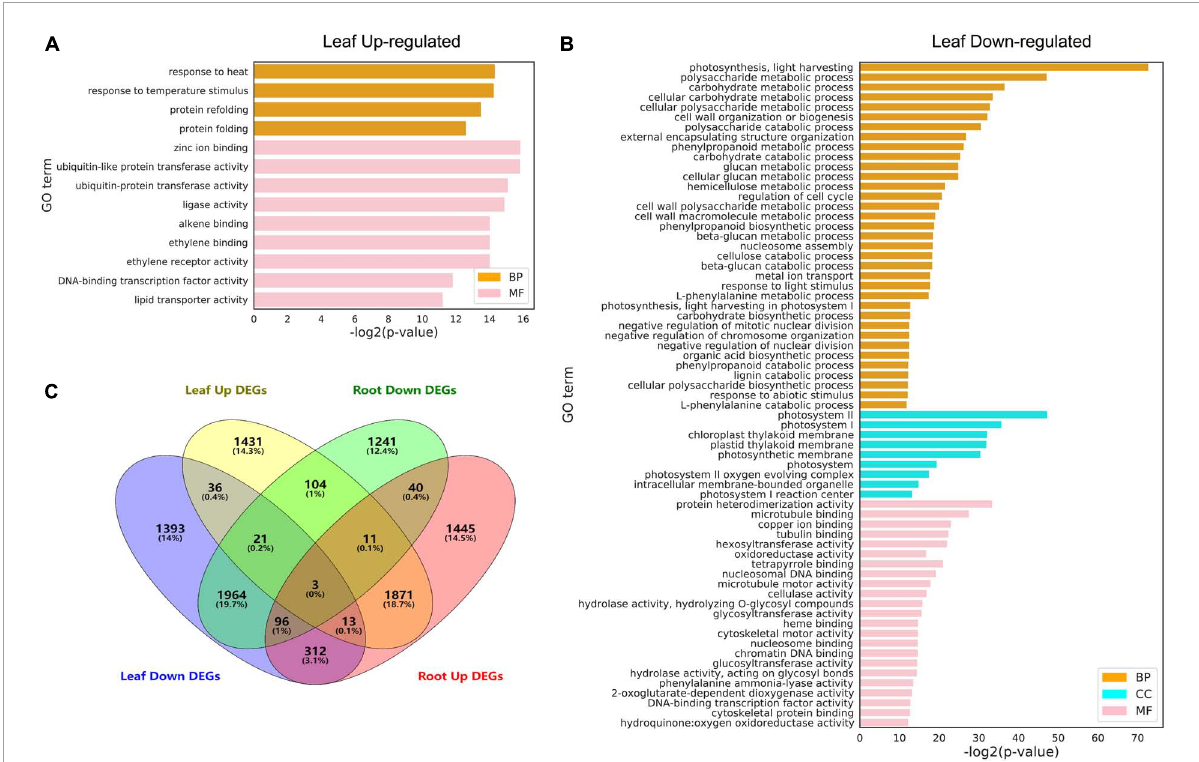
FIGURE6 Gene ontology (GO) analysis of differentially expressed genes (DEGs) under heat stress. (A) Upregulated DEGs in the leaf. (B) Downregulated DEGs in the leaf. (C) Venn diagrams showing DEGs in the leaf and root. GO terms with FDR < 0.01 are shown. The full lists of DEGs and GO terms can be found in Supplementary Tables 6, 7 .